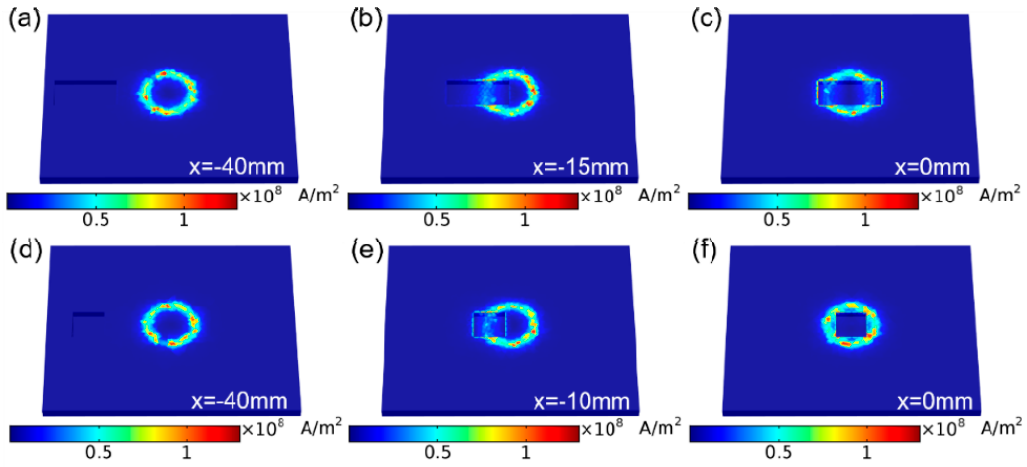
Figure 3. Finite element analysis of the current density distribution on Al plate specimen when the larger defect (30 mm × 15 mm × 3 mm) ( a – c ) and smaller defect (15 mm × 15 mm × 3 mm) ( d – f ) moving from leftmost position ( x = − 40 mm) to the center ( x = 0